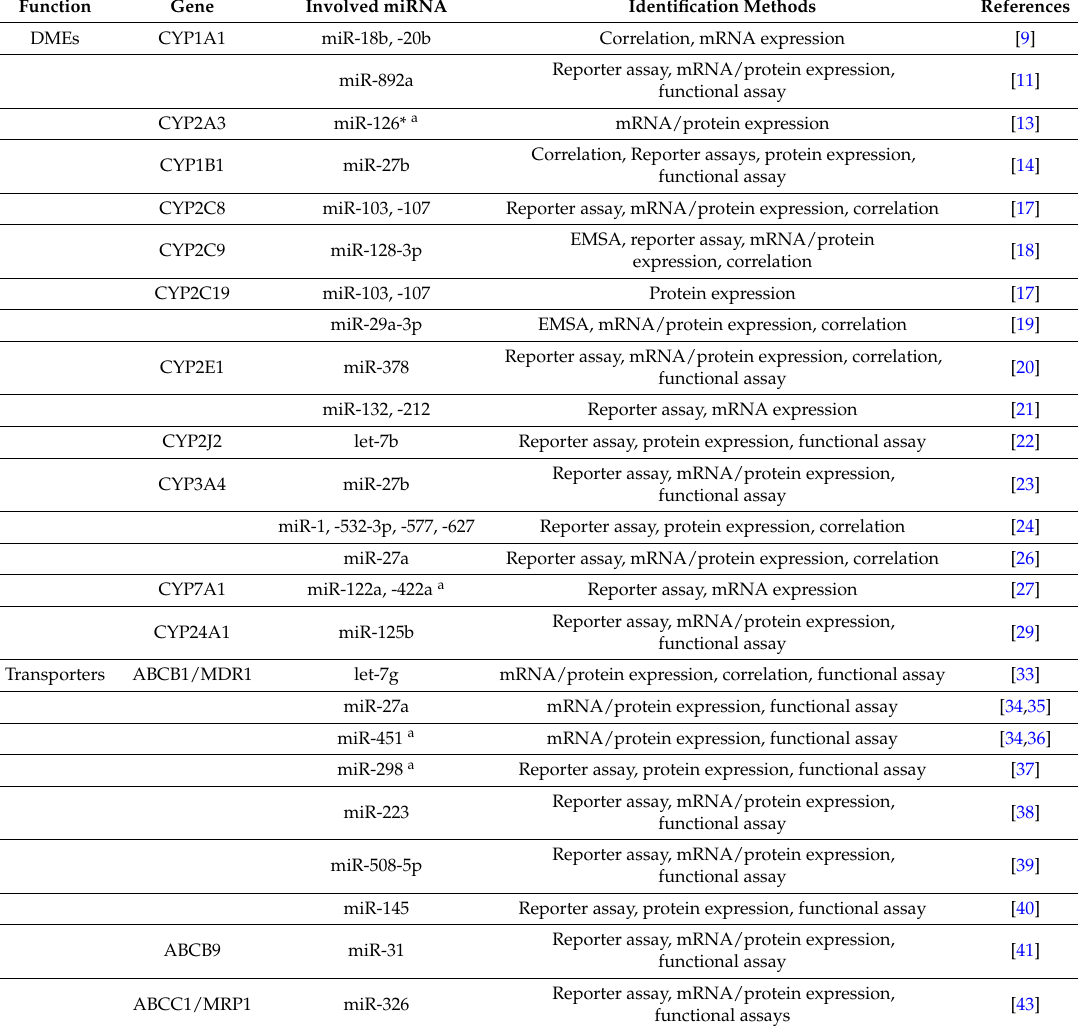
Table 1. MiRNAs reported to regulate drug metabolism related